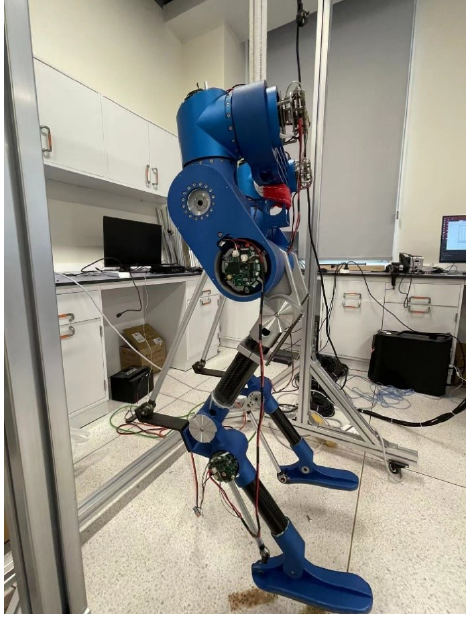
Figure 6. Side view of experimental prototype.